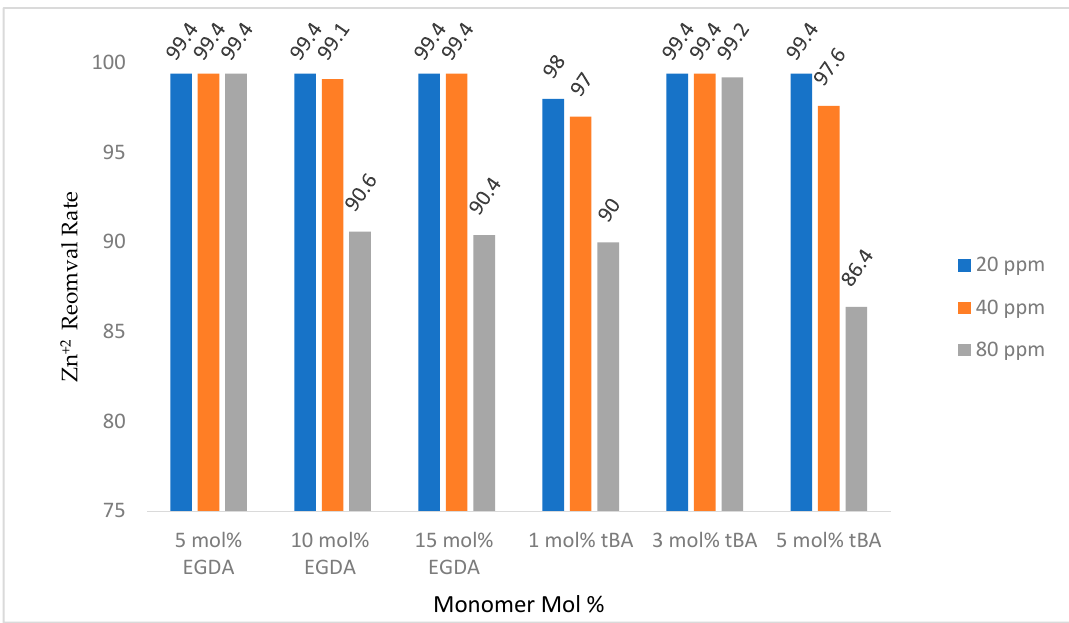
Figure 10. Gravity column removal rates for all tBA and EGDA non-imprinted resins. The ppm values are for Zn +2 solutions. All polymers with varying EGDA contain no tBA. All polymers with varying tBA contain 5 mol % EGDA.